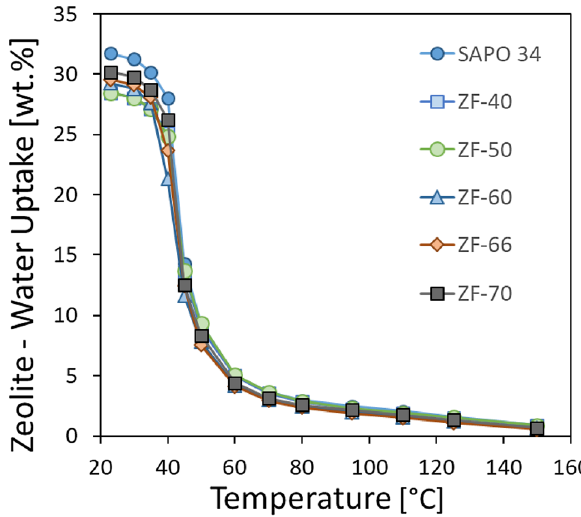
Fig. 9 Filled zeolite efficiency at varying temperature for the compos- ite